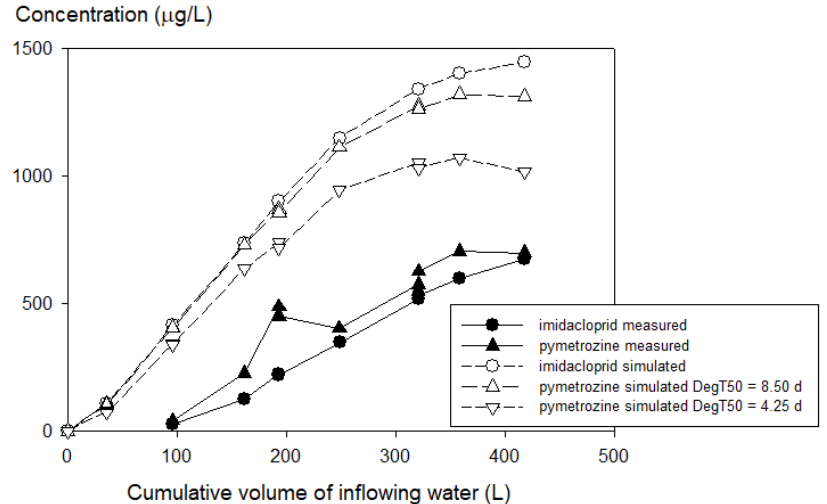
Figure 7. Measured and simulated concentrations of imidacloprid and pymetrozine in the used-water tank as a function of the cumulative water volume flowing into this tank. Simulations were based on first estimates for all parameters except the run with the shorter half-life for pymetrozine. Both measured and simulated concentrations of pymetrozine were multiplied by 2.94/2.25 to account for the di ff erence in dosage between imidacloprid and pymetrozine.